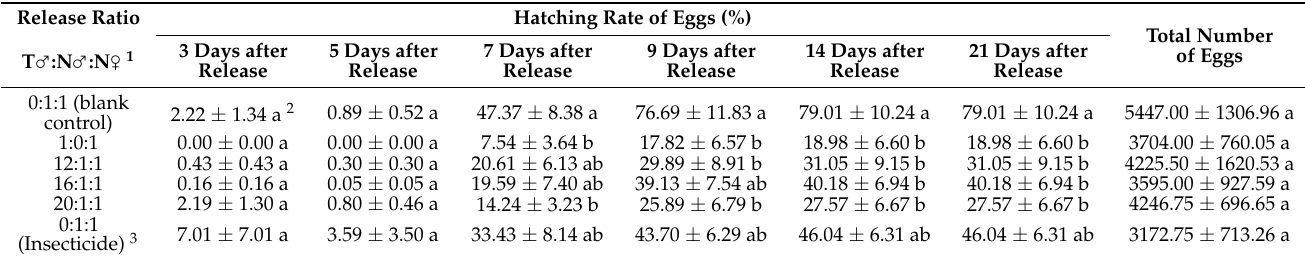
Table 1. Changes in the egg hatching rates in different treatment plots after the release of Spodoptera frugiperda